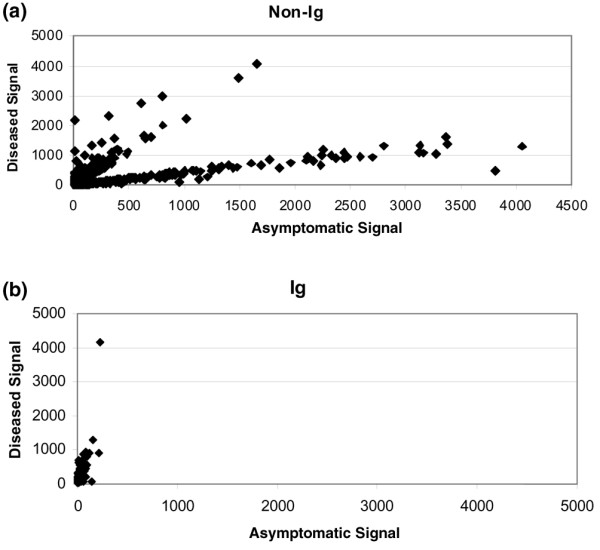
Expression changes in transcripts associated with disease progression. Scatter plot showing the expression levels of dysregulated probe sets expressed in (NZBxNZW)F1 kidneys of mice with lupus nephritis (older mice) (Y axis) compared with expression levels in asymptomatic (younger) mice (X axis). (a) Expression levels of 547 non-immunoglobulin (Ig) probe sets significantly associated with disease, 46% of which are expressed at higher levels in diseased kidney. (b) Expression levels of 195 immunoglobulin probes sets, 100% of which are expressed at higher levels in diseased kidney.